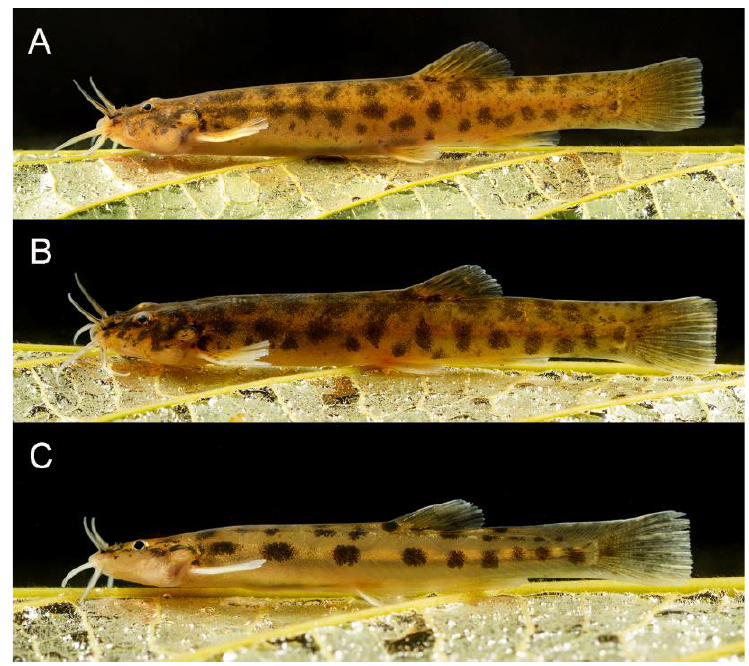
Figure 19. Live specimens of Trichomycterus altipombensis Costa, Katz, Vilardo and Mattos, sp. nov. ( A ) UFRJ 12784, paratype, 59.0 mm SL; ( B ) UFRJ 12784, paratype, 43.0 mm SL; ( C ) UFRJ 12784, paratype, 34.0 mm SL. Table 2. Morphometric data of Trichomycterus altipombensis Costa, Katz, Vilardo and Mattos sp.